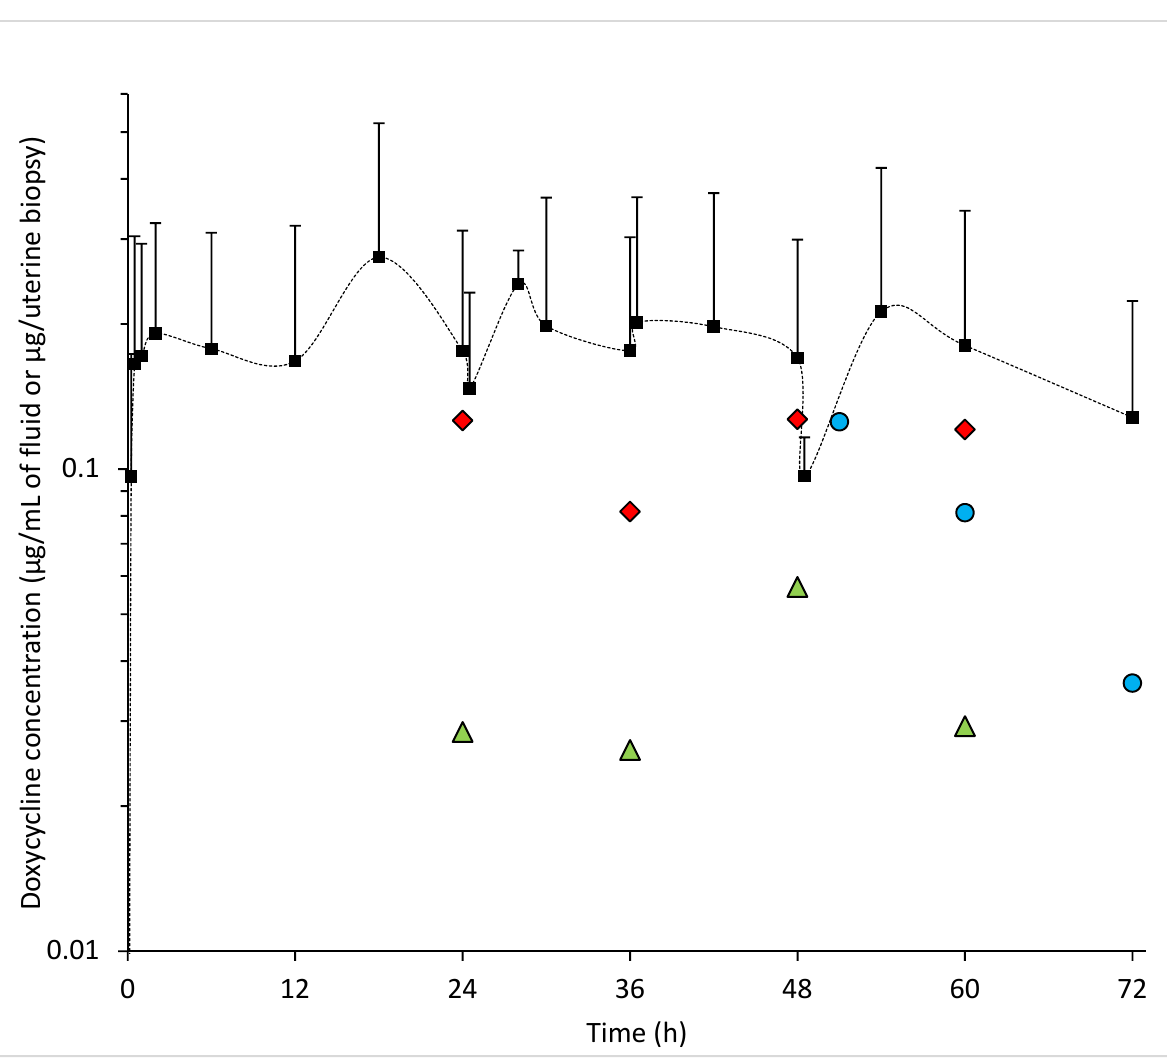
Figure 4. Mean + SD serum doxycycline concentration (square), and means of doxycycline concentrations in urine (red diamond), synovial fluid (green triangle) and endometrium biopsy (blue circle) vs. time during intragastric administration of doxycycline at 10 mg/kg q12 h from 0 to 48 h in 8 healthy jennies. The dash line connects the serum data point for ease of reading but does not represent continuum data.